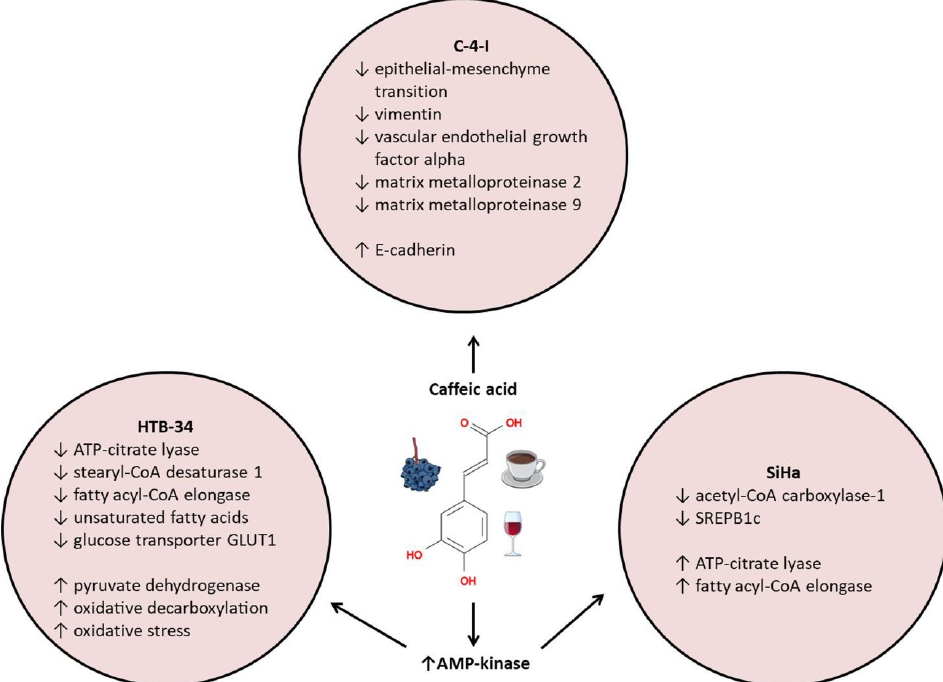
Figure 3. Effects of caffeic acid on metastatic human cervical cancer cells. SREPB1c means sterol regulatory element-binding proteins, and CoA means coenzyme A.